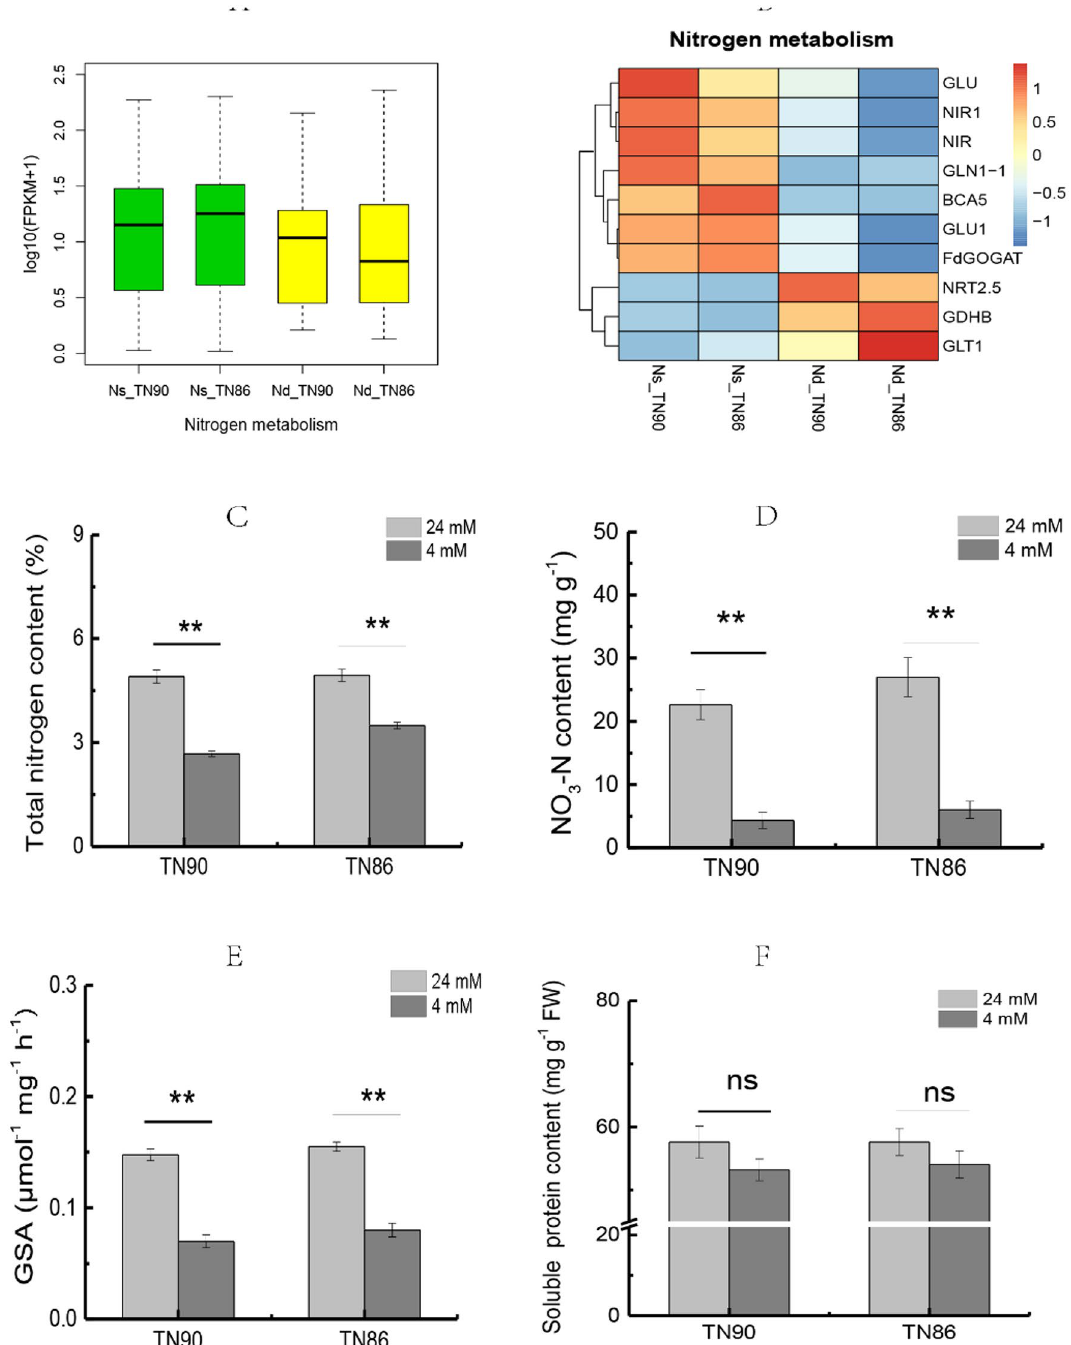
Figure 3. Nitrogen metabolism of burley tobacco under N-deficiency conditions. ( A ) Primary transcripts associated with nitrogen metabolism; ( B ) expression pattern of genes related to nitrogen metabolism; ( C ) total nitrogen content; ( D ) NO 3 -N content; ( E ) GSA activity; ( F ) soluble protein content. Symbol ** indicate a statistically significant differences between nitrogen-deficient and nitrogen-sufficient conditions at p < 0.01. ns indicates no statistically significant difference between nitrogen-deficient and nitrogen-sufficient conditions at p < 0.05 and p < 0.01, respectively. Error bars of leaf biomass indicate standard error of the means (n =